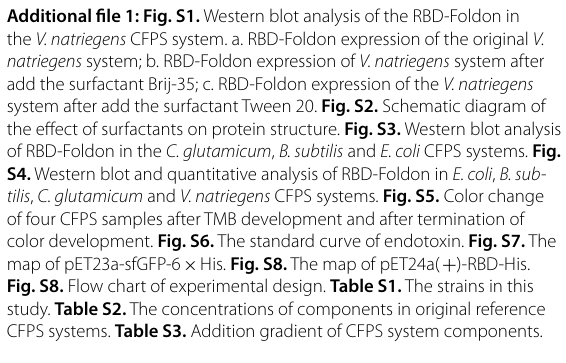
His. Fig. S8. The map of pET24a( )-RBD-His. × + Fig. S8. Flow chart of experimental design. Table S1. The strains in this study. Table S2. The concentrations of components in original reference CFPS systems. Table S3. Addition gradient of CFPS system